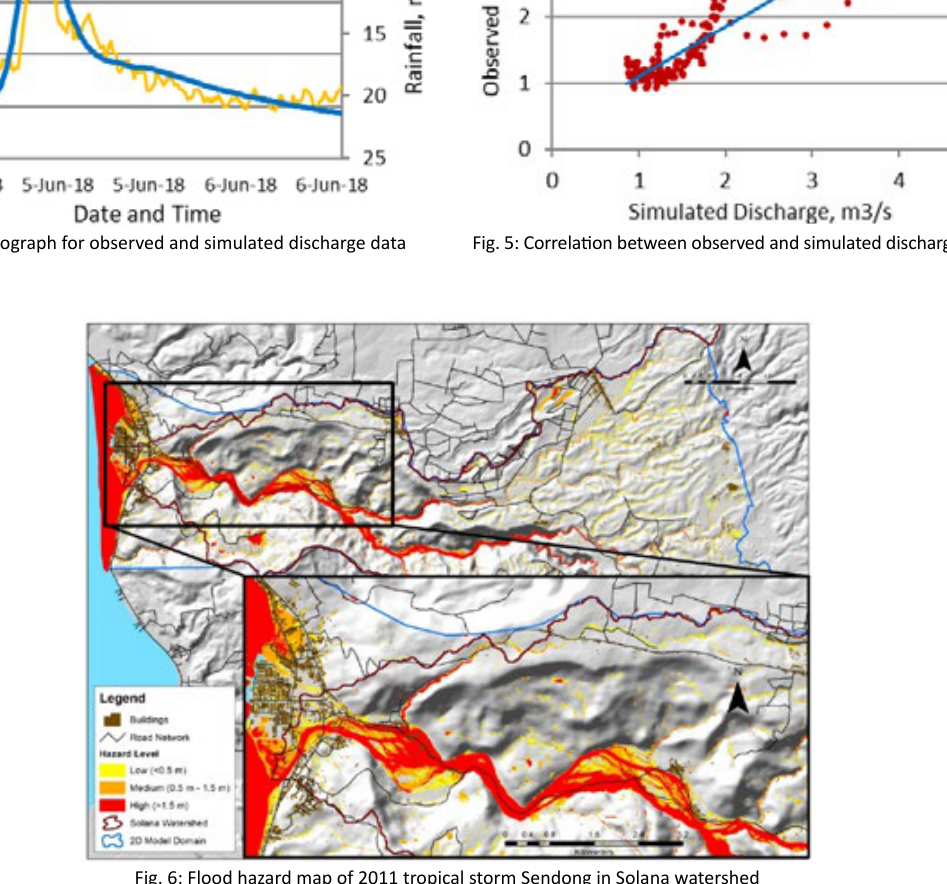
Fig. 6: Flood hazard map of 2011 tropical storm Sendong in Solana watershed